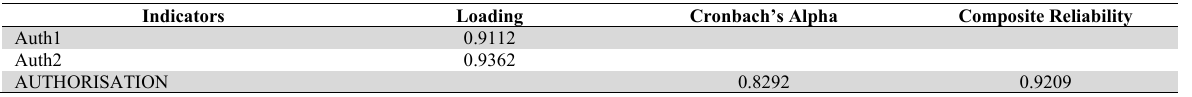
The revised Authorisation scale